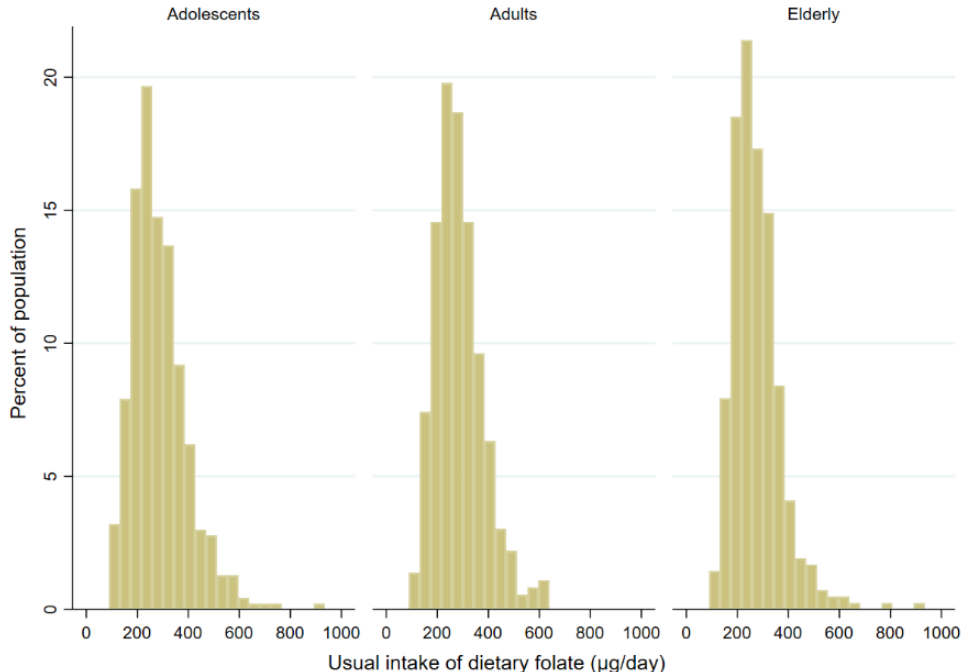
Figure 1. Histograms of estimated usual daily intake of folate for all three age cohorts (adolescents: 10–17 years; Adults: 18–64 years; Elderly: 65–74 years).